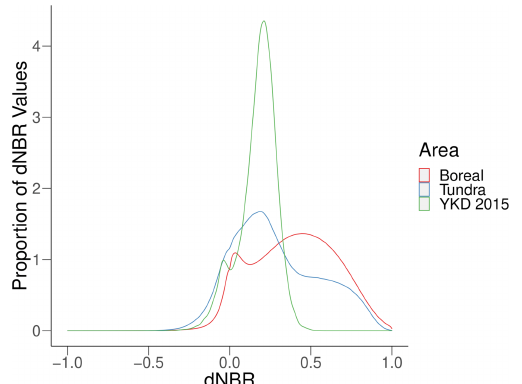
Figure A8. The distribution of dNBR values for the 2015 YKD fire season compared to all fires in boreal and tundra systems in Alaska between the years 1989 and